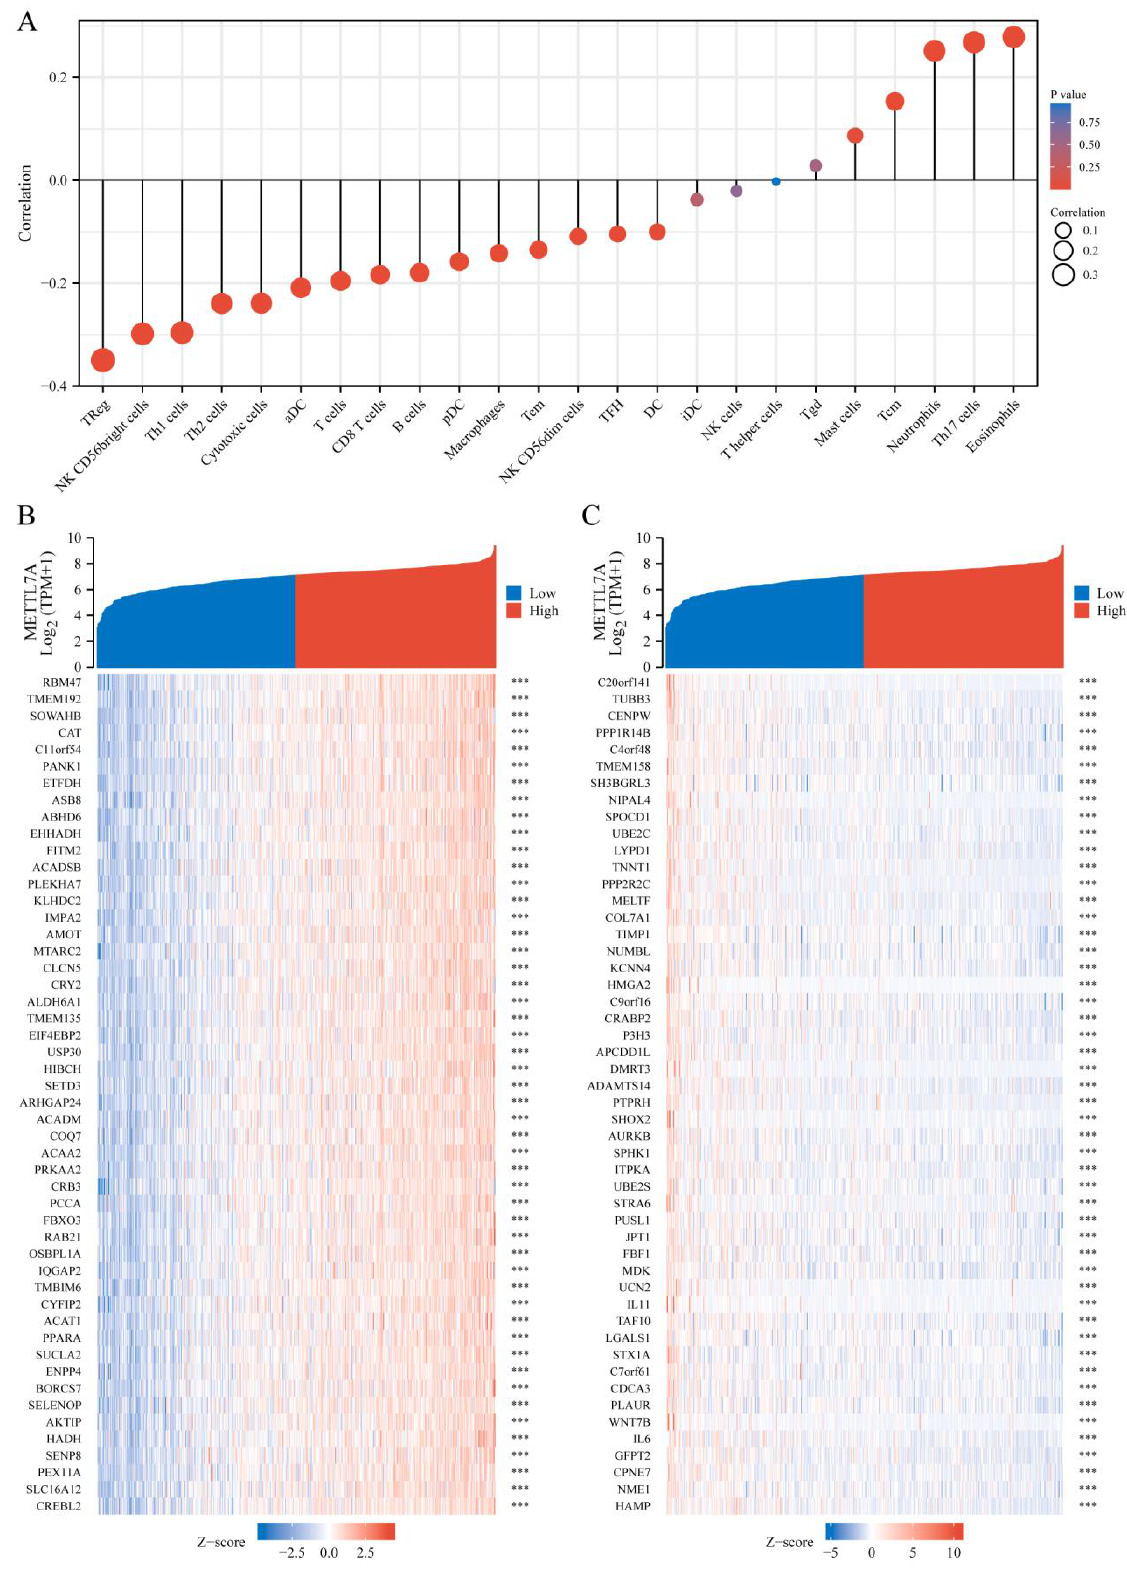
Figure 7. Immune infiltration and co-expression gene analysis of METTL7A in KIRC. ( A ) the forest plots show the correlation between METTL7A and immune cells. ( B ) the gene co-expression heatmap of the positive correlation with METTL7A in KIRC. ( C ) the gene co-expression heatmap of the negative correlation with METTL7A in KIRC (***, p <